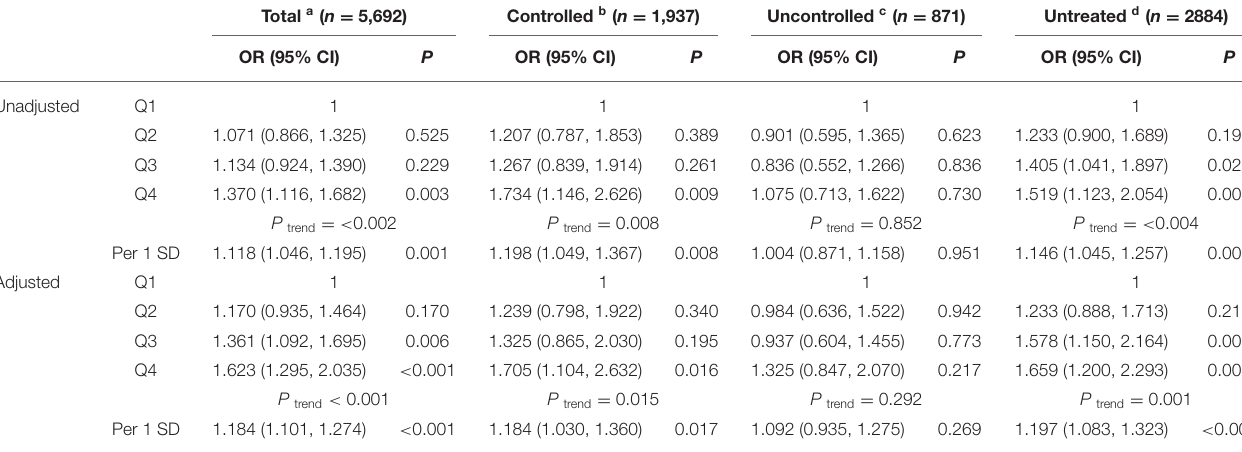
TABLE 3 | Association between the risk of microalbuminuria and heart